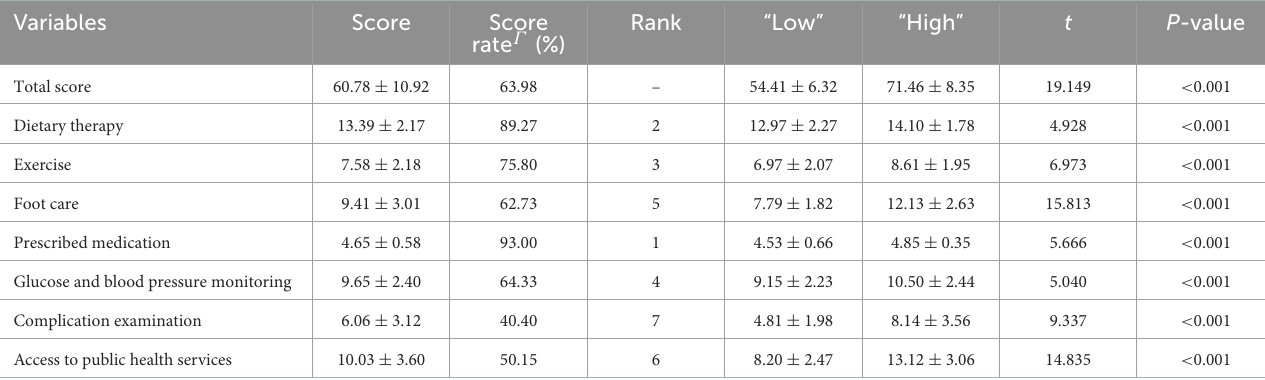
TABLE 2 Total and dimension scores of behavior subscale.